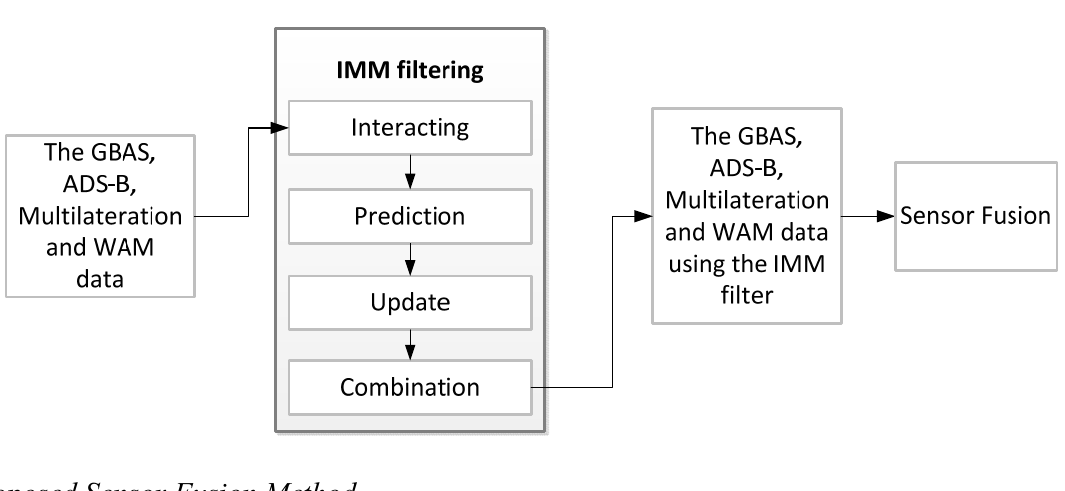
Figure 2. Flowchart for application of IMM